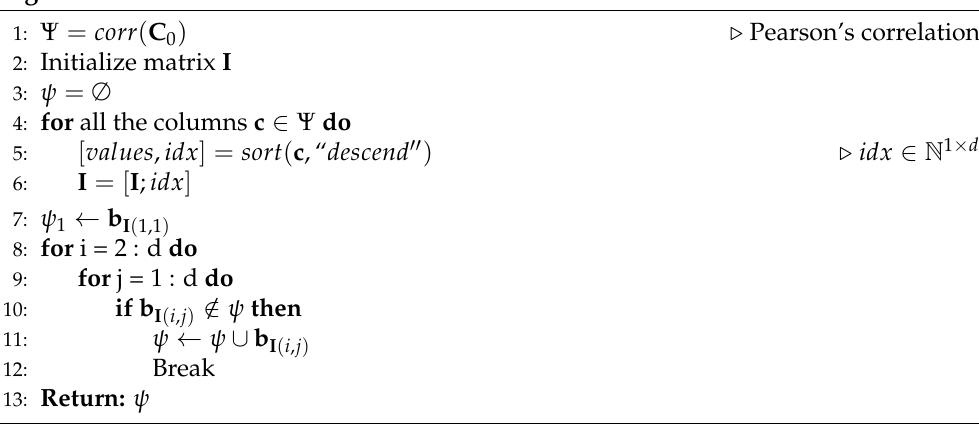
Algorithm 1 Most correlated bands